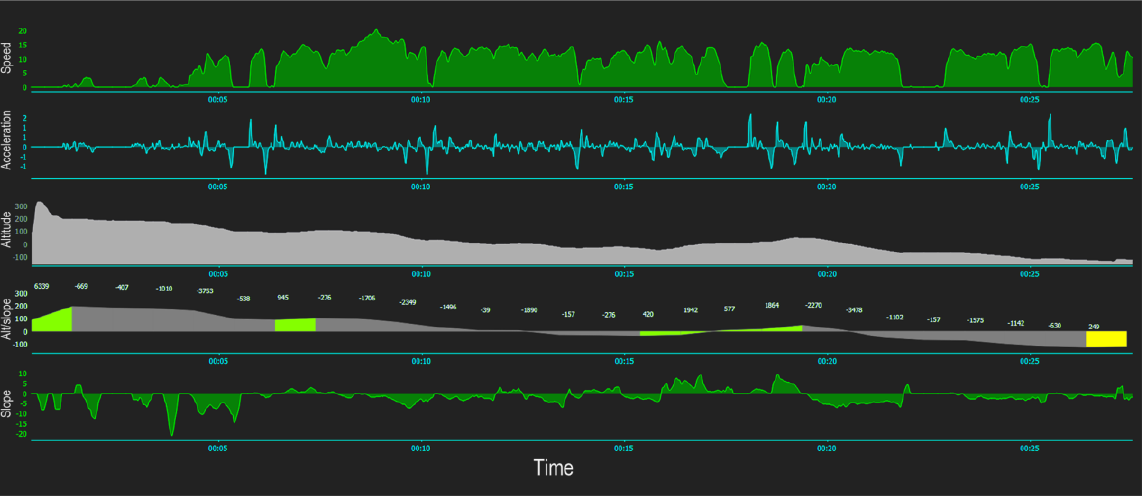
Figure 6. Speed, acceleration, altitude, gradient, and slope data from a pedestrian journey with a wearable camera.